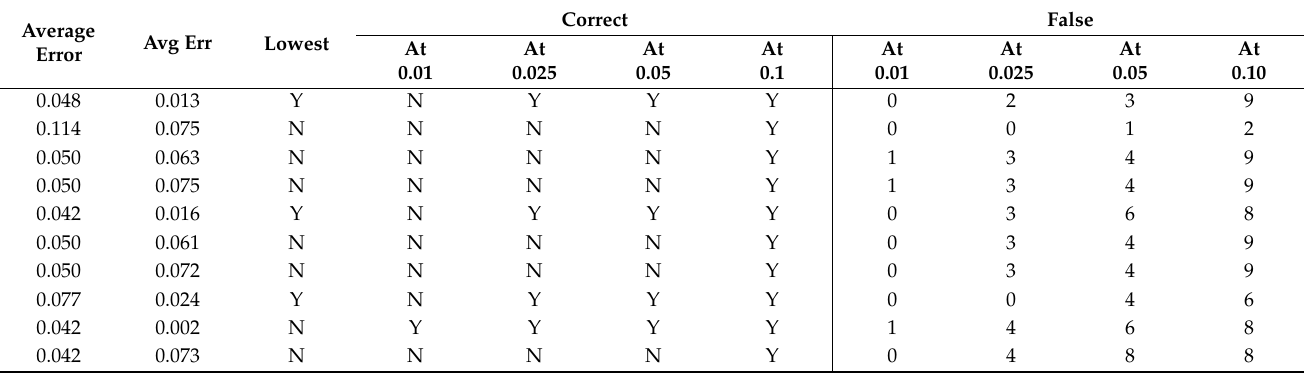
Table A108. Set 2, trials 11–20 data (actual PR